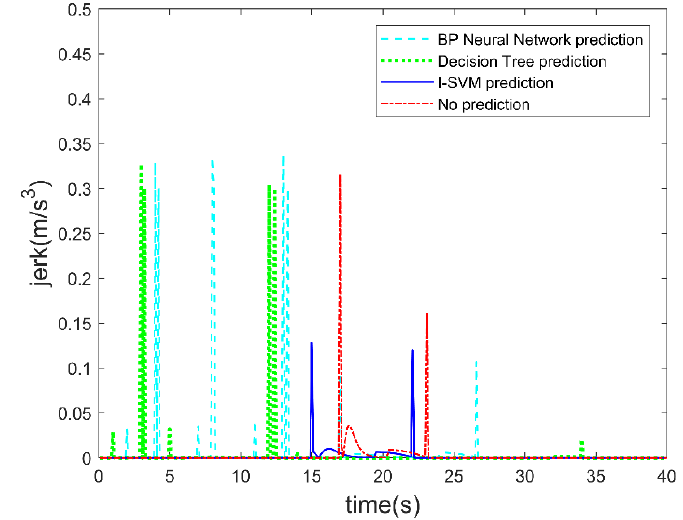
Figure 13. Jerk of the autonomous vehicle.